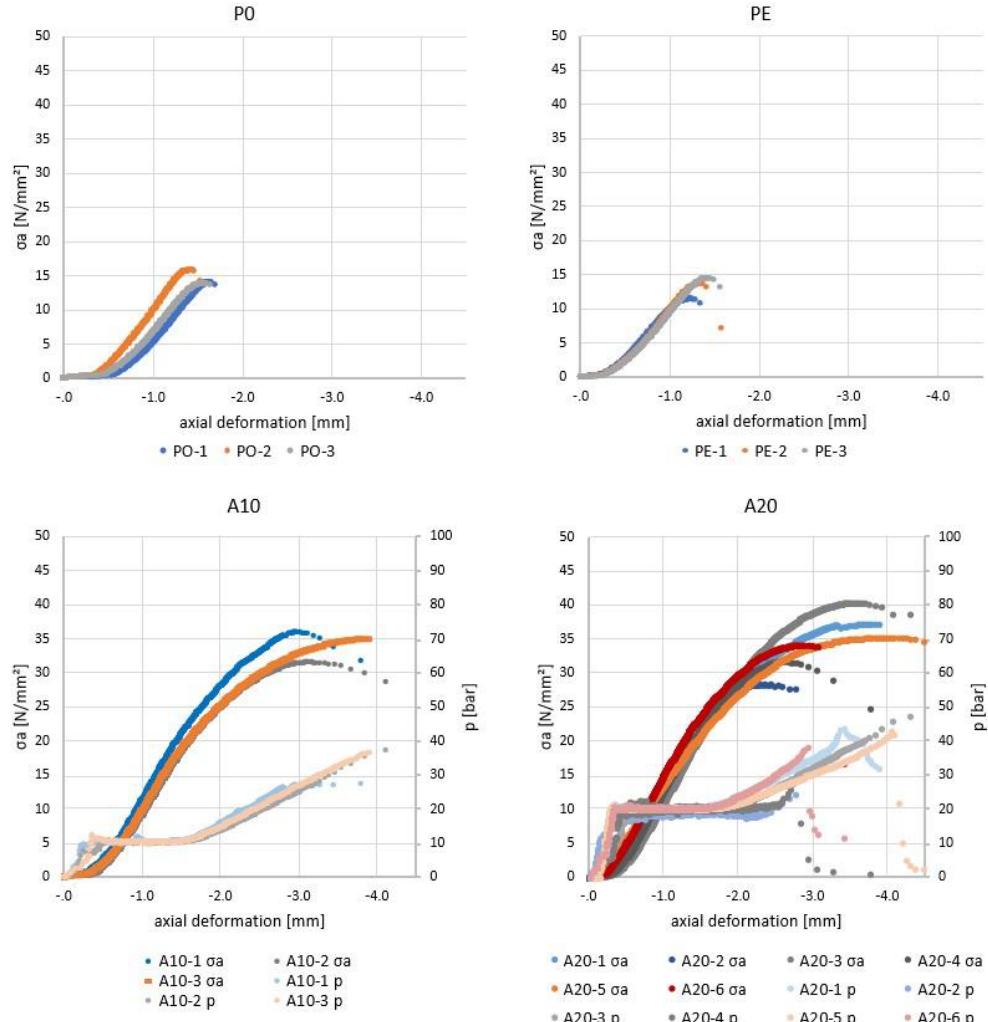
Figure 6. Stress-deformation diagrams for test series P0, PE, A10 and A20, including the applied hydraulic pressure for test series A10 and A20.